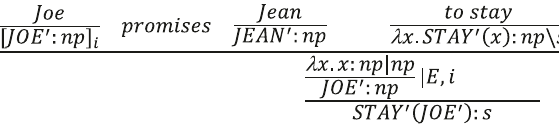
Figure 3: Partial derivation for (5).